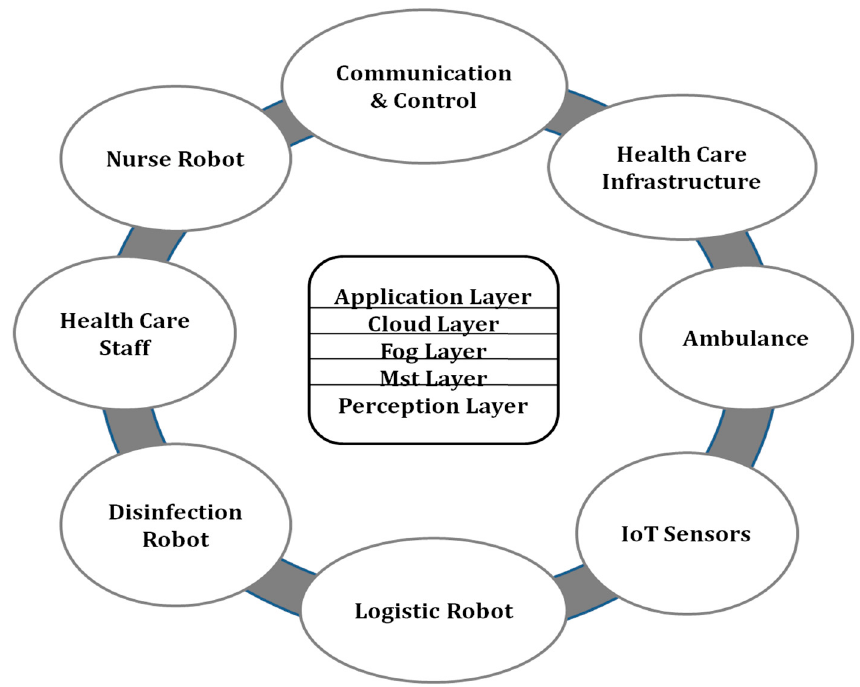
Figure 2 . Robotics for healthcare applications . Figure 2. Robotics for healthcare